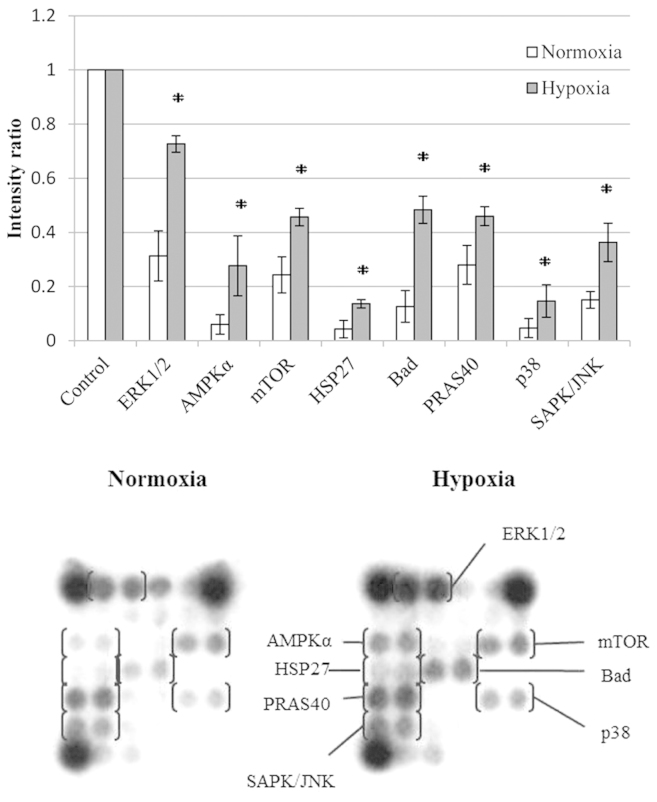
Activation of intracellular signaling nodes by hypoxia. The lower panel presents chemiluminescent images produced with the PathScan Intracellular Signaling Array kit. The upper panel shows the pixel intensity ratio of activated signaling nodes. *P<0.05, normoxia vs. hypoxia; values are presented as the mean ± standard deviation. ERK, extracellular signal-regulated kinase; HSP, heat shock protein; mTOR, mammalian target or rapamycin; Bad, B-cell lymphoma-2-associated death domain; JNK, c-Jun-N-terminal kinase; AMPK, adenosine monophosphate-activated protein kinase; PRAS40, proline-rich Akt/PKB substrate 40 kDa.